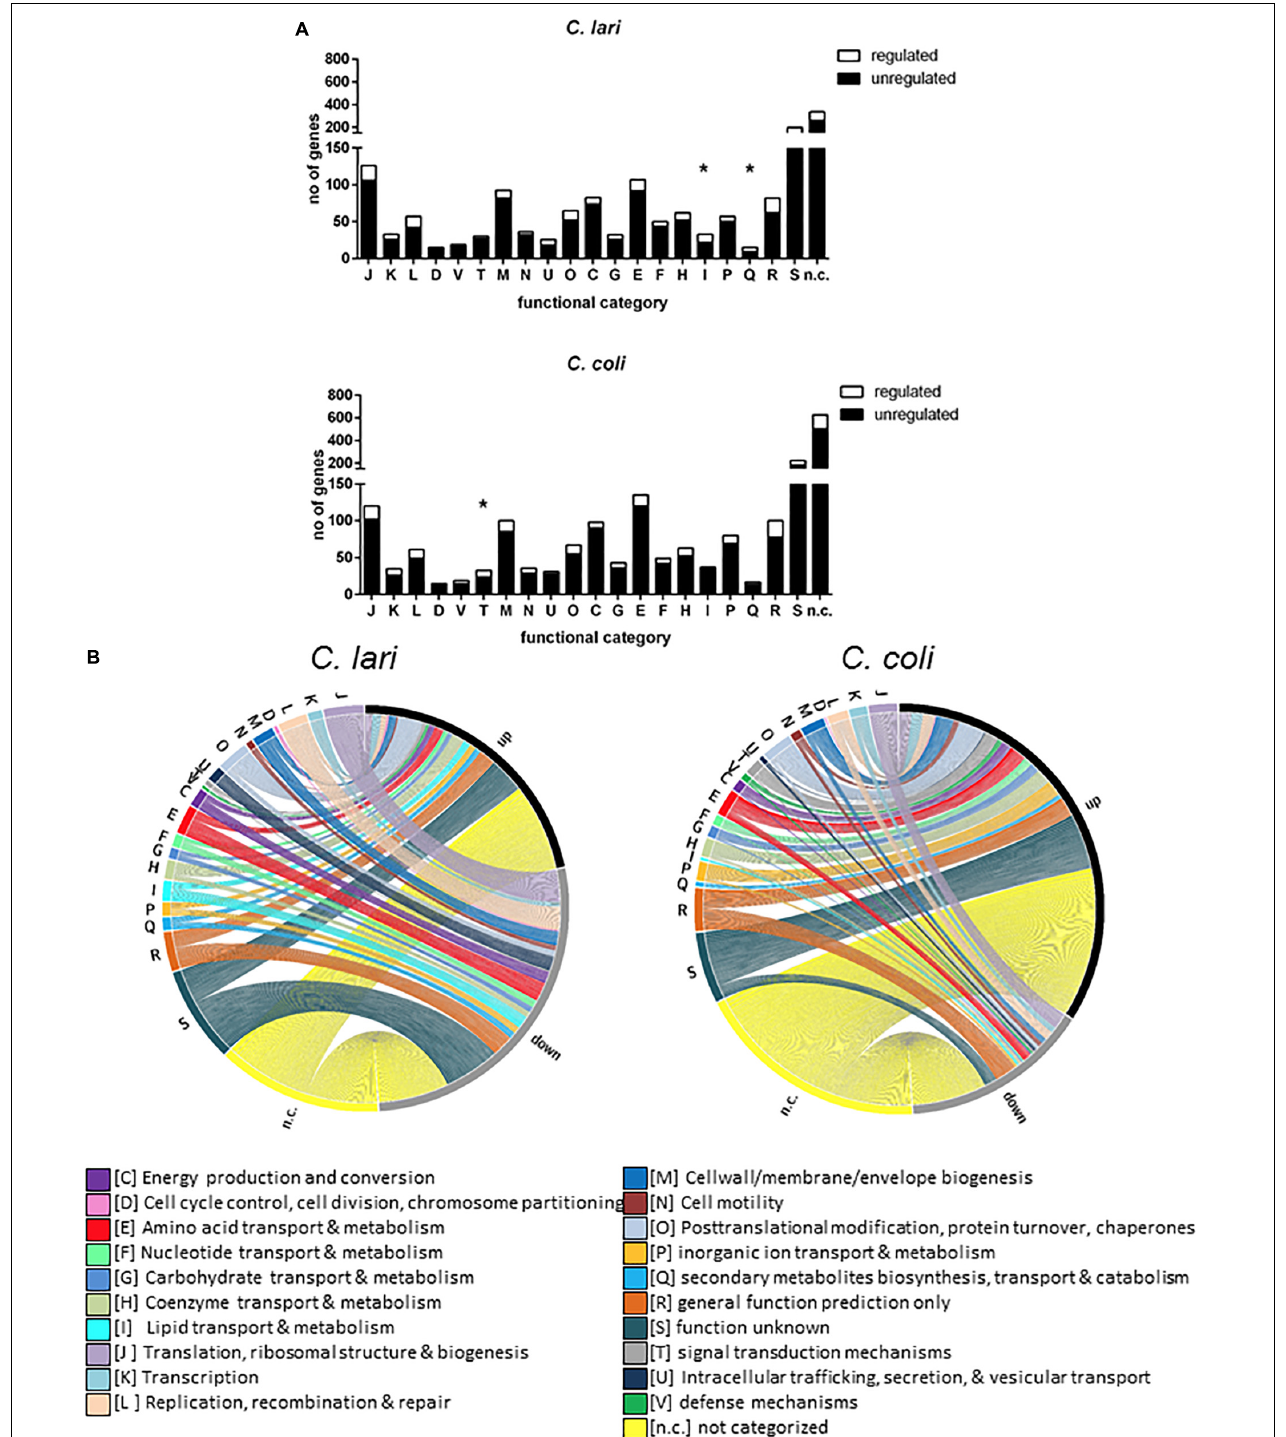
FIGURE 4 | Genes differentially expressed after heat stress according to functional groups. The genes differentially expressed after 30 min of heat stress were shown according to their functional classification (obtained from the evolutionary genealogy of genes: Non-supervised Orthologous Groups http://eggnog.embl.de/version_4.0.beta) for C. coli RM2228 and C. lari RM2100. (A) Total number of regulated and unregulated genes assigned to each functional category were shown for C. lari and C. coli . Significant enrichment for each category were calculated by Fisher’s exact test (* p < 0.05). (B) The figure was created with the open source tool Circos (http://circos.ca). The thickness of each connection displays the log 2 fold change of gene expression whereas the ending of connection displays if the gene expression is up- or down-regulated.